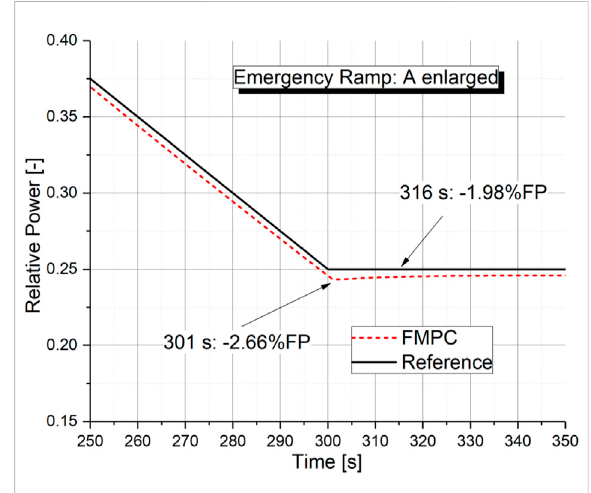
FIGURE 10 Simulation results for the working condition: emergency ramp